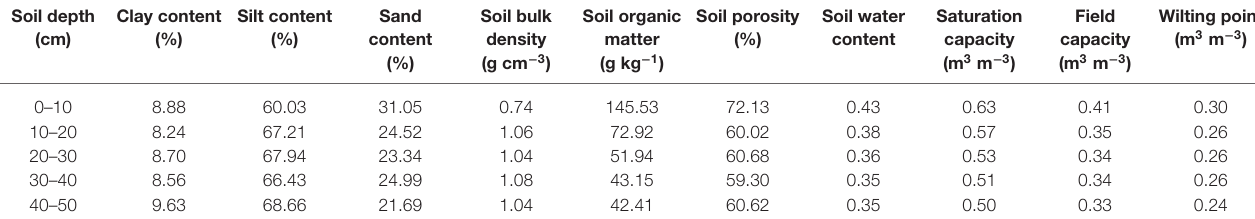
TABLE 1 | The basic soil properties around the lysimeter